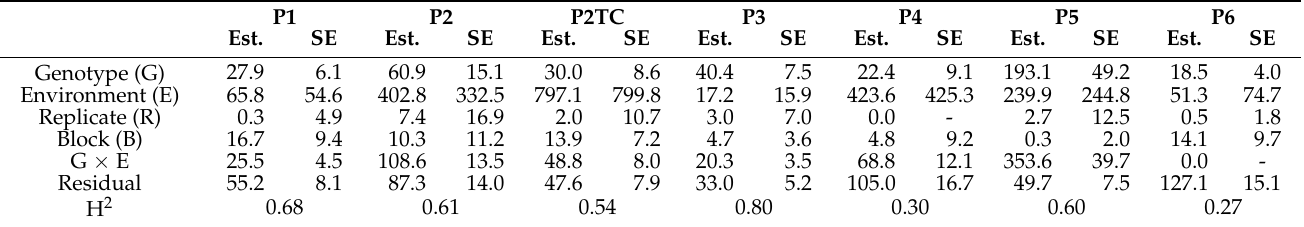
Table 3. Variance components (Est.) with standard errors (SE) and entry-mean heritabilities (H 2 ) for stem